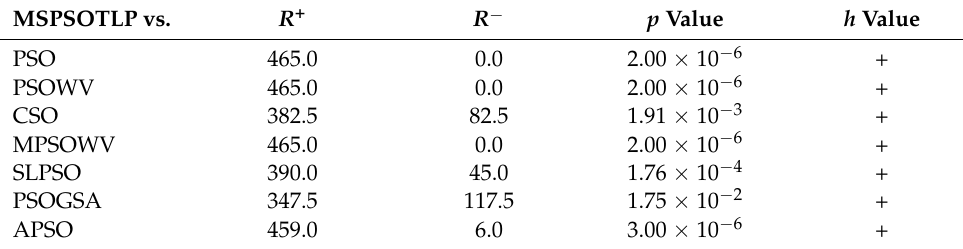
Table 6. Pairwise comparisons by Wilcoxon signed rank test between MSPSOTLP and each peer algorithm. MSPSOTLP vs.